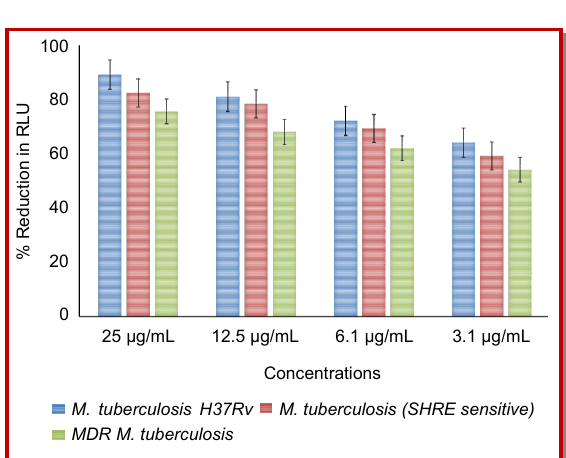
Figure 2: Anti-tuberculosis activity of quercetin standard and clinical M. tuberculosis